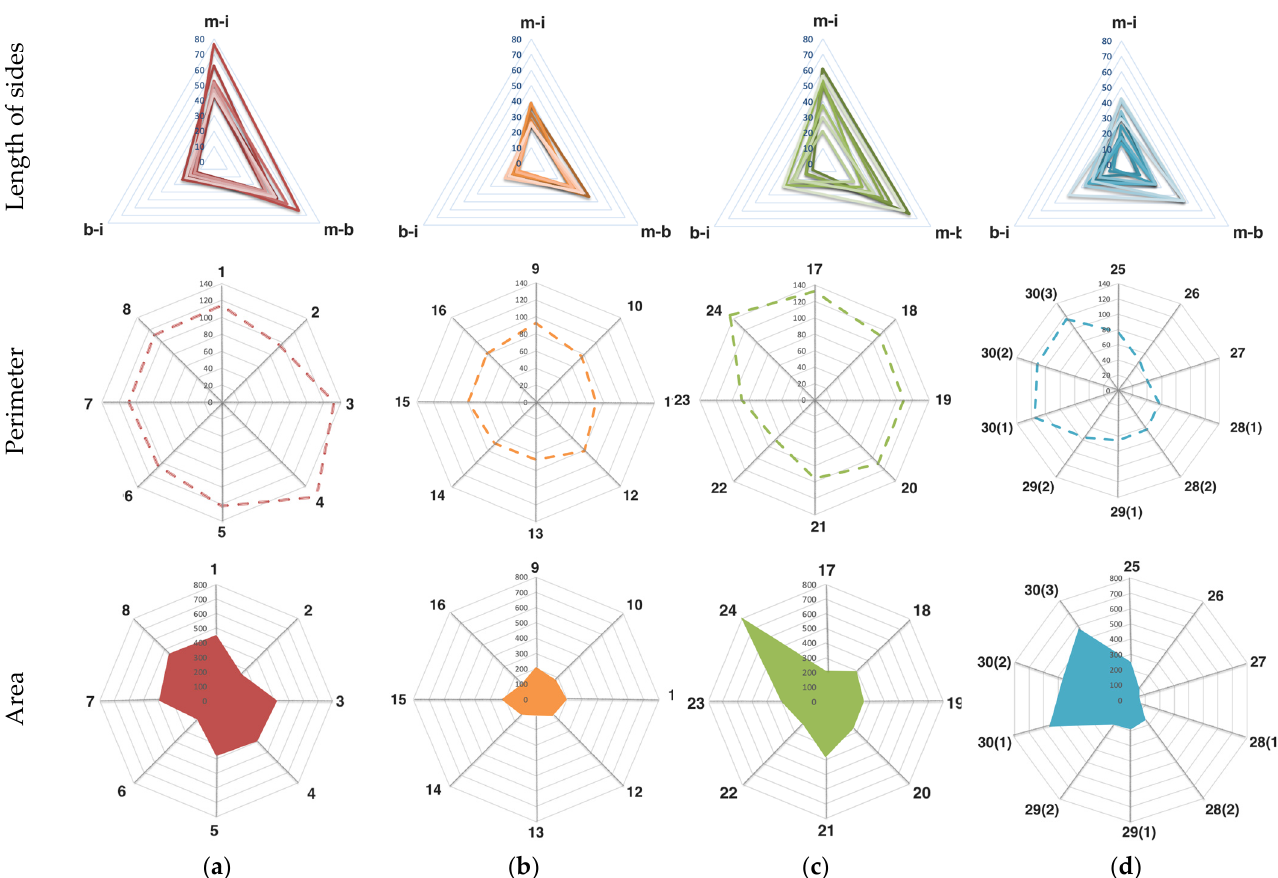
Figure 17. Color differences CIEDE2000 between the main and “intermediary” (m–i), main and background (m–b), background and “intermediary” (b–i) colors in Sections I ( a ), II ( b ), III ( c ), and IV ( d ). Perimeters and areas of the triangles in the Sections I ( a ), II ( b ), III ( c ), and IV ( d ).